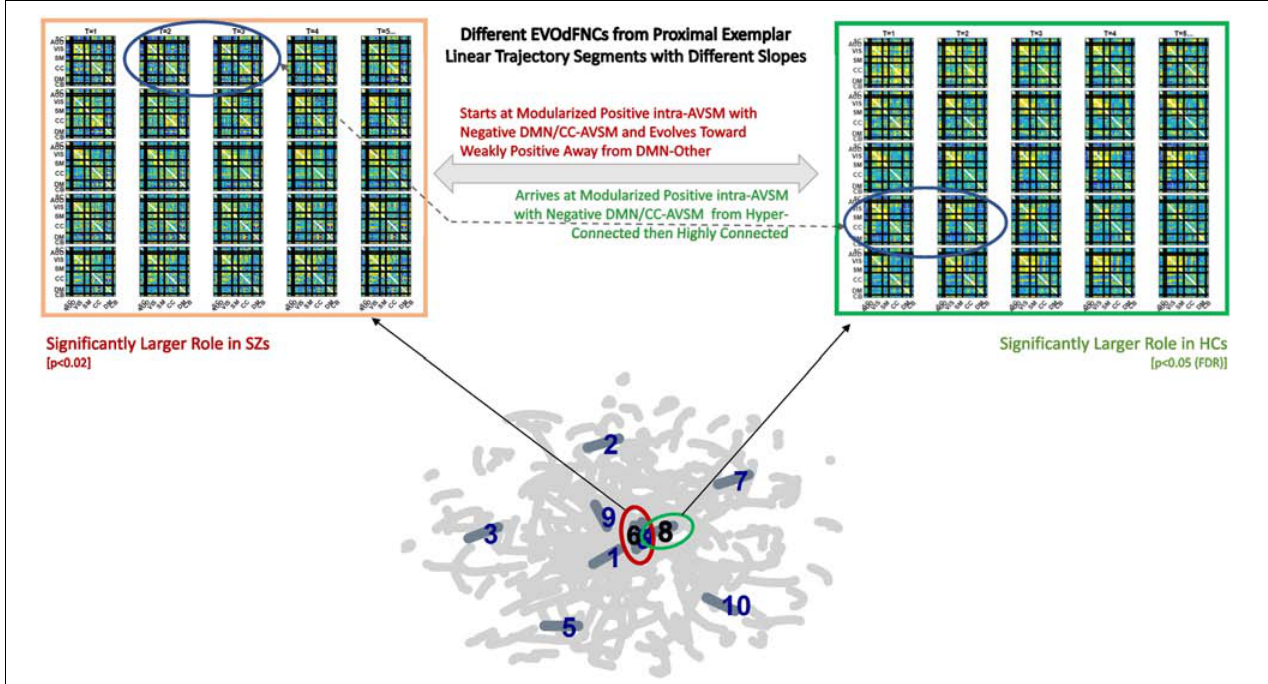
FIGURE 17 | Top row shows two EVOdFNCs: leftmost in thick orange box is significantly ( p < 0 . 025 ) more important in SZ before correction for multiple comparisons; the rightmost in the thick green box is significantly more important in HCs after correction for multiple comparisons. Note the similarity between the circled frames in both EVOdFNCs arising from the corresponding 2D linear trajectory exemplars that pass very near each other but have different slopes; the EVOdFNC with higher representational importance in healthy controls corresponds to the more horizontal exemplar (#8 in the thick green circle), whereas the nearby exemplar (#6 in the thick red circle) lifts to EVOdFNC 6, which has significantly higher RI in SZs. Although the EVOdFNCs in the top row are built from 2D linear trajectory exemplars that are proximal, especially near their endpoints, their differing slopes (i.e., angles of approach) cause them to represent dynamic trajectories sufficiently different as to be to represent high-dimensional dynamic contexts that are characteristic in one case of HCs and in the other of SZs.